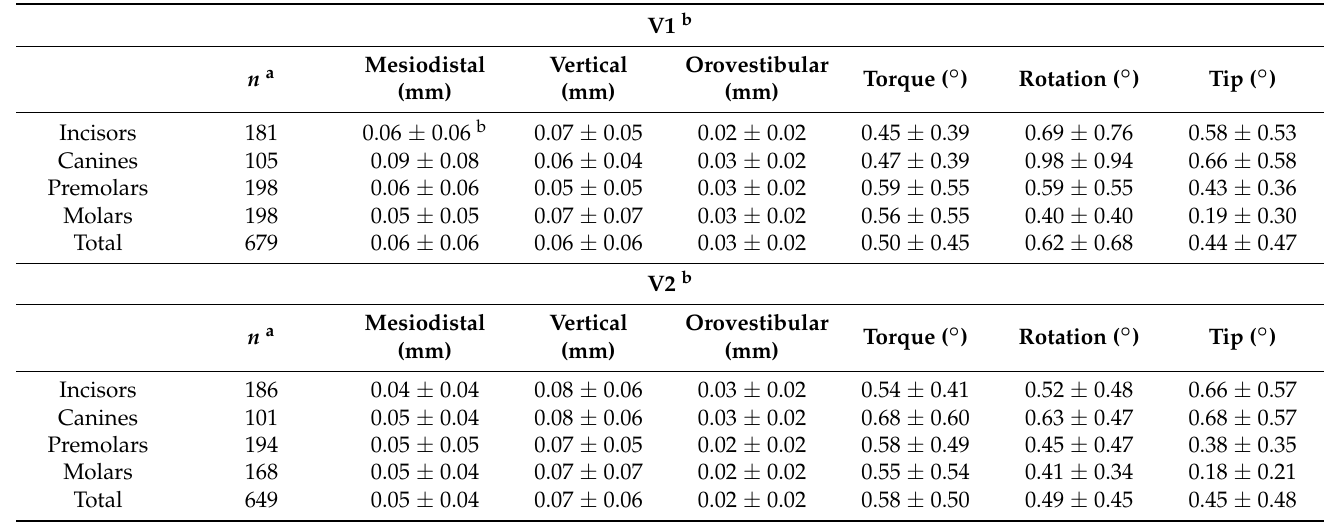
Table 1. Absolute mean values and standard deviations between virtually planned and postbonding positions for version 1 (V1) and version 2